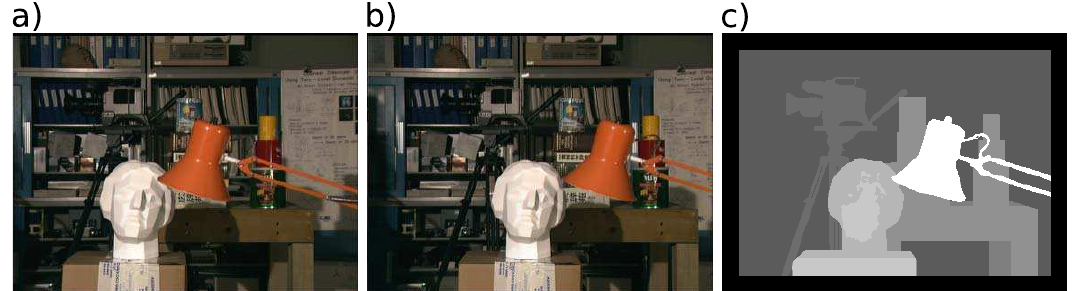
Figure 6. Tsukuba data set. From left to right: left image, right image, desired disparity map.